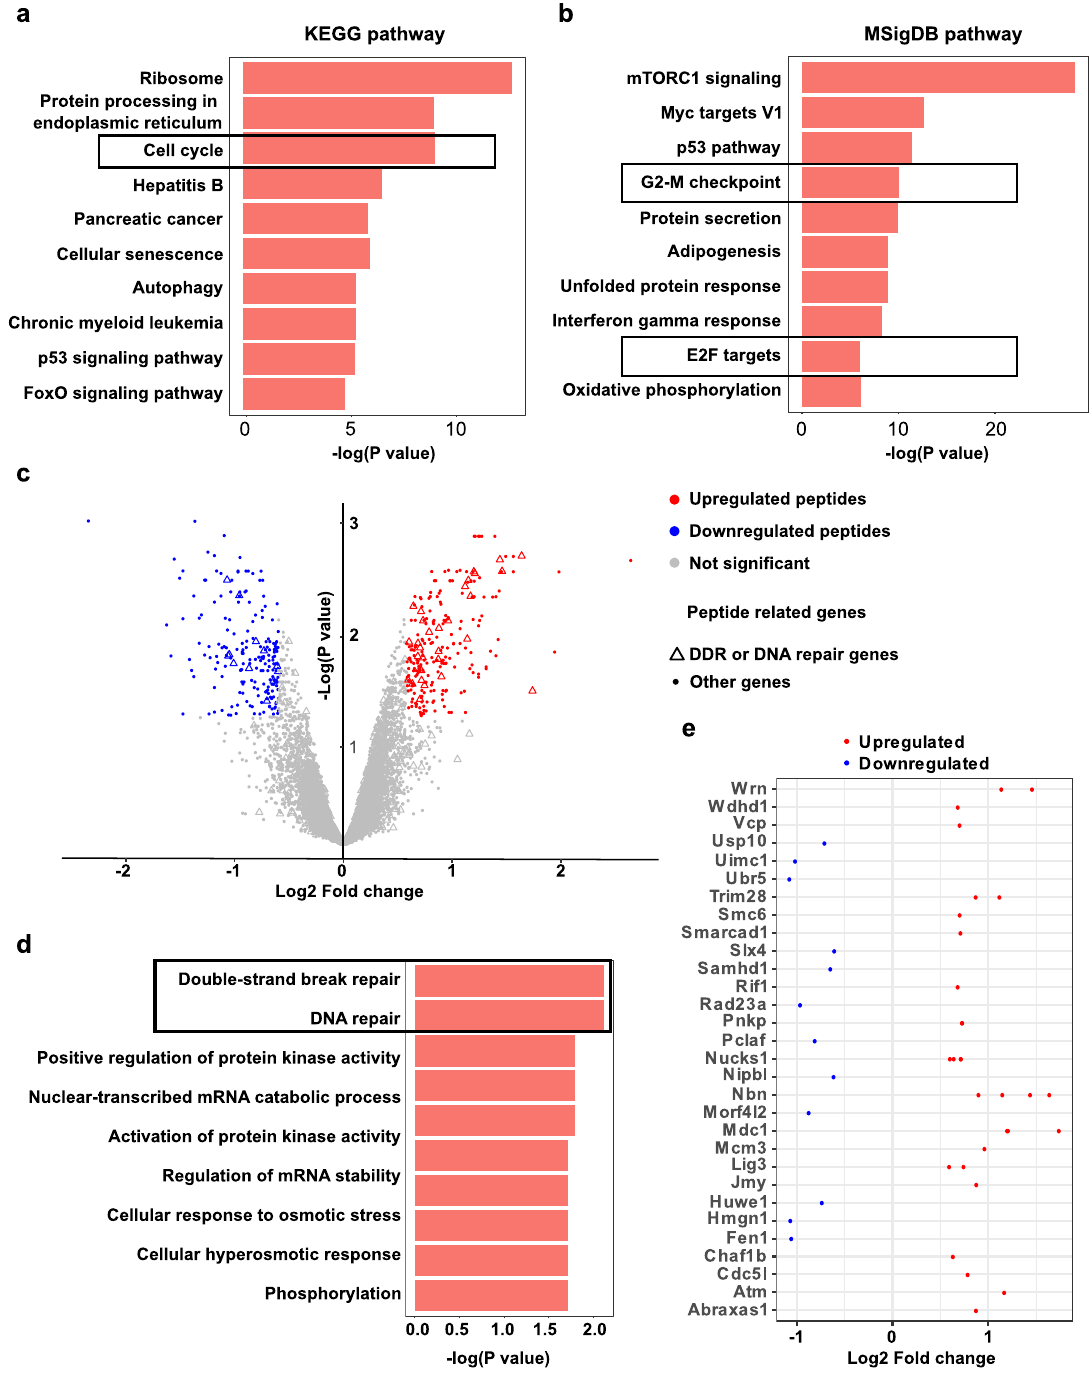
Fig. 5 Transcriptomic and phosphoproteomic analyses reveals a replication stress signature caused by the oncogenic CALR. a RNA- sequencing identi fi ed differentially expressed genes in Ba/F3-MPL CALR mutated cells compared to CALR WT cells. The gene-set enrichment analysis was performed by Enrichr. The top10 most enriched KEGG pathways are shown. b The top 10 most enriched MSigDB pathways are shown in the gene-set enrichment analysis. c Volcano plot of differentially phosphorylated peptides identi fi ed by phosphoproteomic analysis. Each dot represents a phosphorylated peptide. A statistical signi fi cance threshold was set as at least a 1.5- fold change of abundance difference between the compared groups with a p -value lower than 0.05. The red and blue dots indicate upregulated and downregulated peptides, respectively, in the CALR mutant group. d The top 10 most enriched gene ontology biological processes are shown in the gene-set enrichment analysis of the differentially phosphorylated peptides. e Depiction of the 42 differentially phosphorylated peptides related to DNA damage response and repair pathways. Each dot represents a peptide. When multiple peptides of one gene are shown, it indicates the protein has more than one phosphorylation site that was identi fi ed. Upregulated/Downregulated indicates up or downregulation of the peptides in the CALR mutant group compared to the wild- type group.